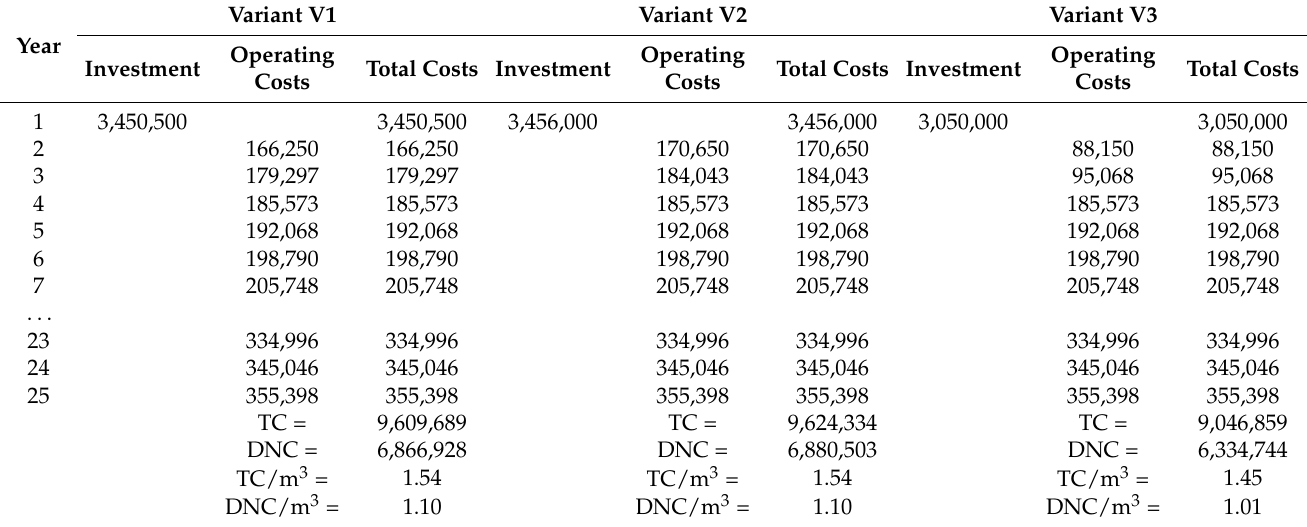
Table 3. Projection of investment and operating costs of the WWTP